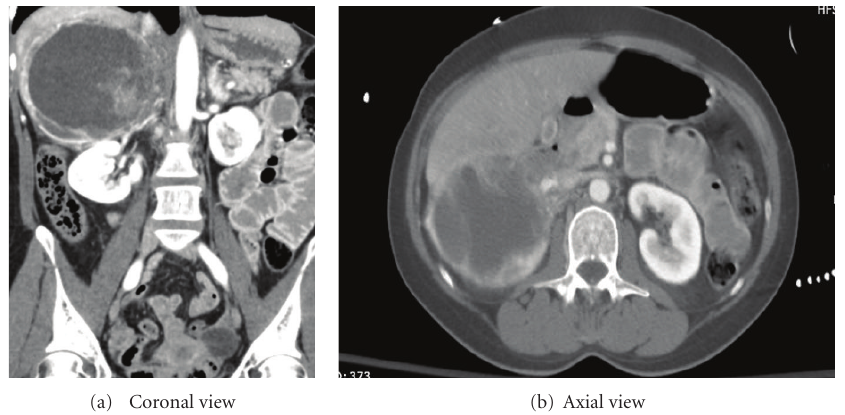
Figure 1: Two views of 11.4cm ∗ 1.4 cm ∗ 1.7 cm adrenal mass actively extravasating right adrenal